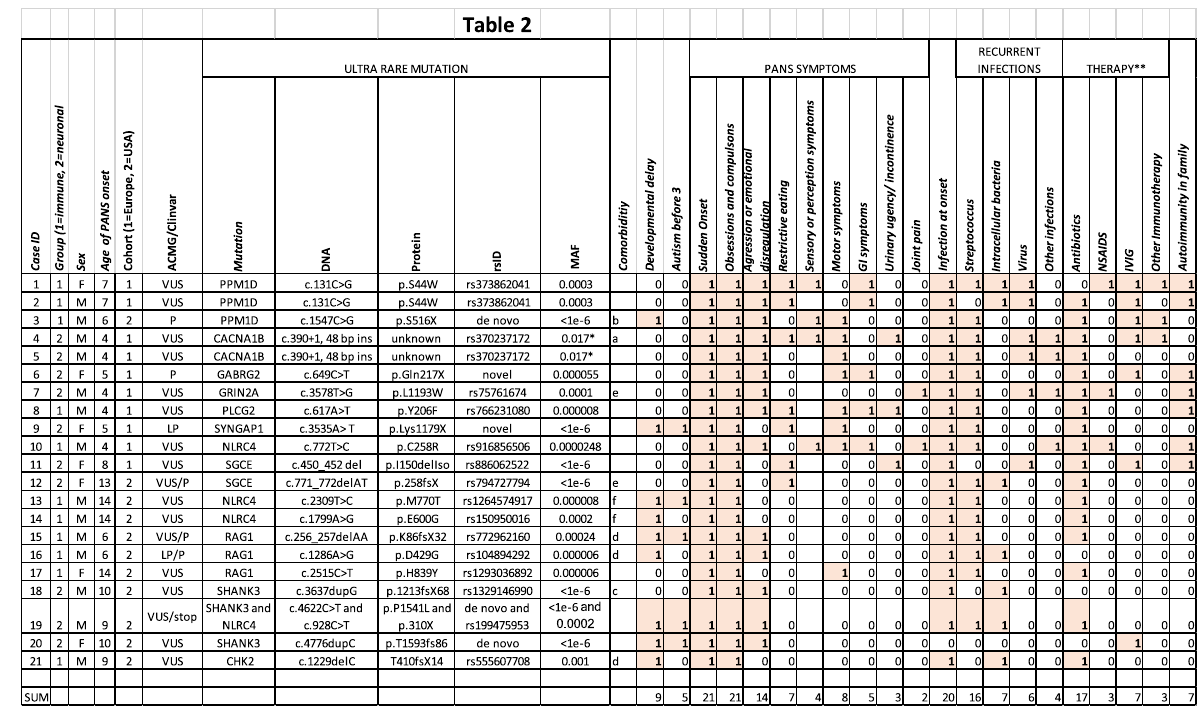
Table 2. Summary of cases. Patient demographics, genetic variants, and brief clinical description. ACMG American College of Medical Genetics, VUS variant of unknown or uncertain significance, LP likely pathological, P pathological, MAF minor allele frequency, OCD obsessive compulsive disorder, GI gastrointestinal. **Denotes treatment with clinical response for PANS symptoms. Comorbidities: a: psoriasis and hematological malignancy, b: Jansen de Vries Syndrome, c: Phelan-McDermid syndrome, d: Mannose-binding lectin deficiency, e: dyslexia, f: atrial septal defect, marfanoid body habitus. Infections include